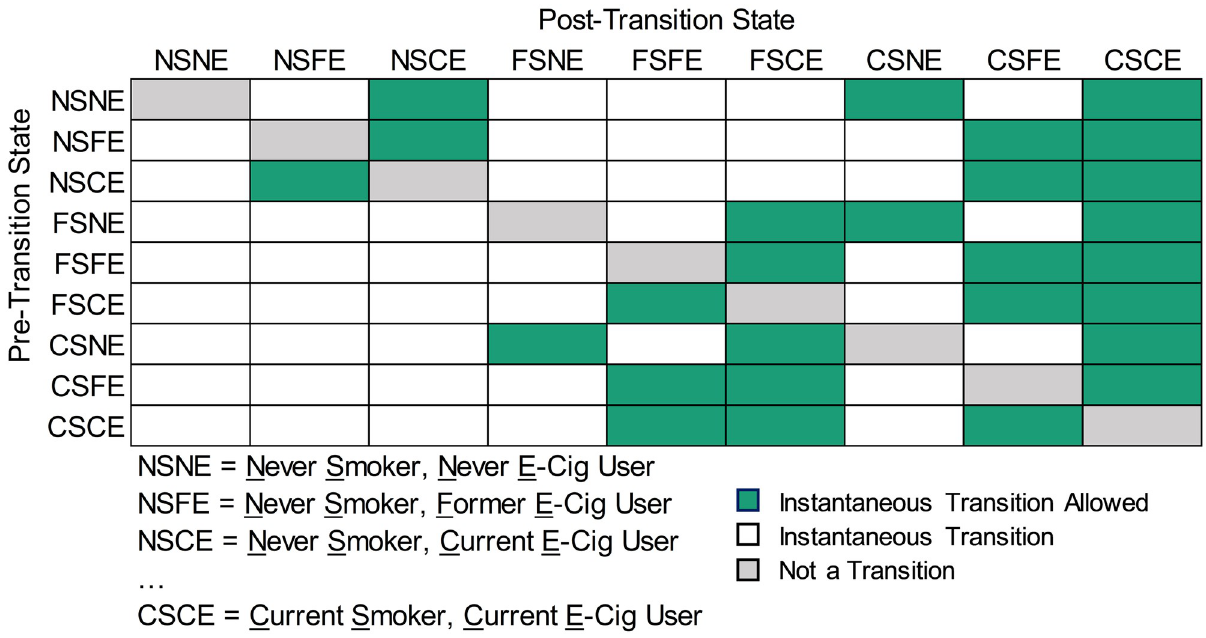
Fig 2. Allowed and disallowed instantaneous transitions in the continuous-time Markov multi-state model of cigarette smoking and e-cig use states. Continuous time Markov multi-state models do not require exact transition times to be observed and allow multiple transitions to occur between observations. They therefore require allowed instantaneous transitions to be specified. Allowed instantaneous transitions from the indicated pre-transition smoking and e-cig use state (row) to the indicated post-transition state (column) are in green. Disallowed instantaneous transitions are in white. We disallowed transitions that would entail never users going directly to a former use state and those that would entail former users or current users going to a never use state. Cells in gray are those reflecting staying in the same state.